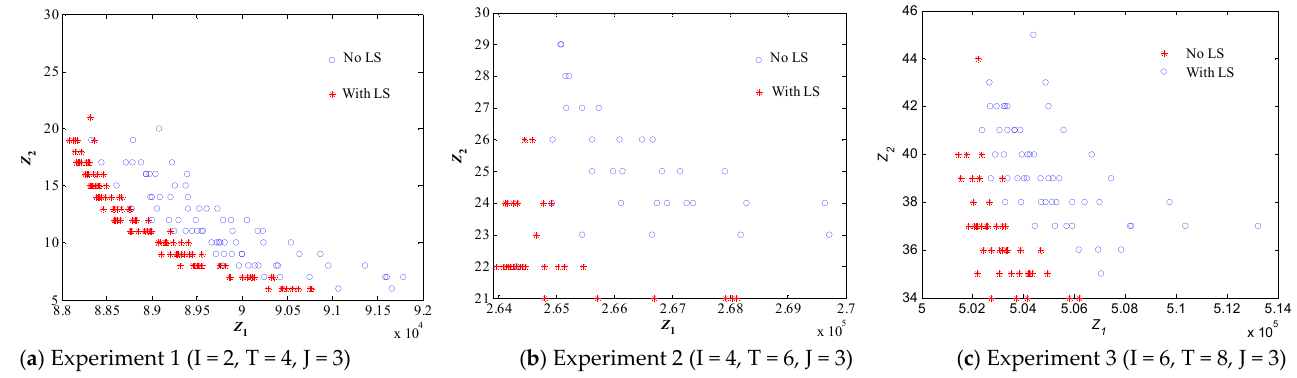
Figure 5. Effect analysis of LS algorithm.